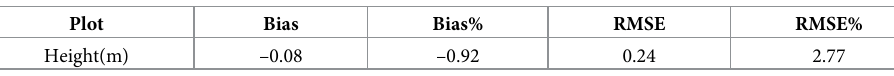
Table 4. The results of the trees